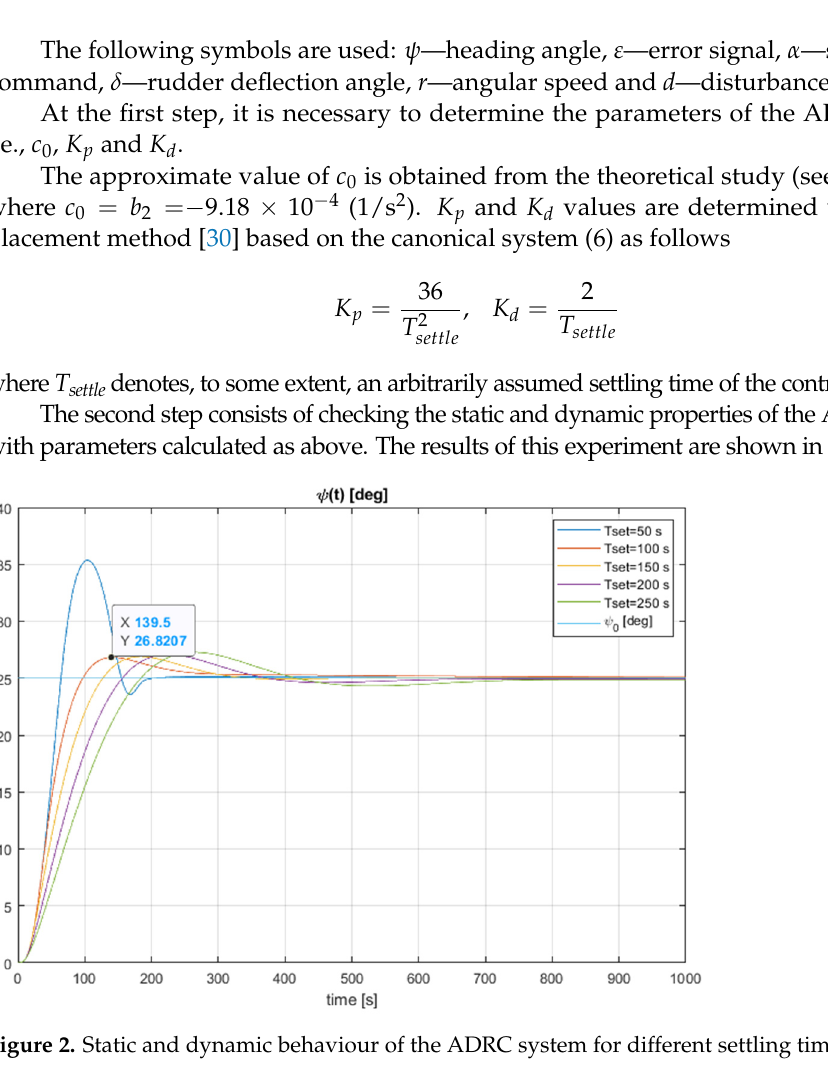
The following symbols are used: ψ —heading angle, ε —error signal, α —steering gear command, δ —rudder deflection angle, r —angular speed and d —disturbances.